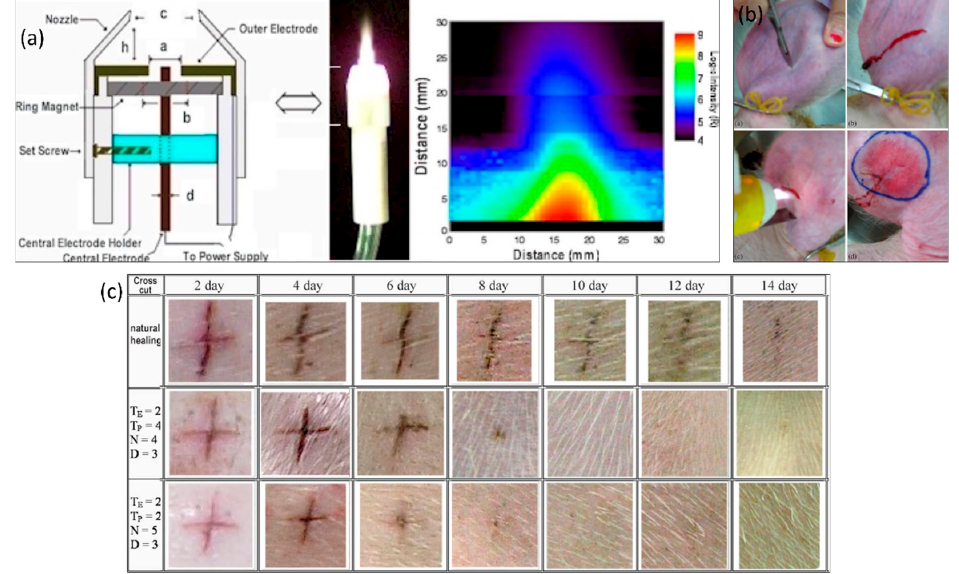
Figure 12. ( a ) The portable plasma spray designed by Kuo [218], ( b ) cutting an artery and leaving the bleeding to stop normally (top row); with plasma treatment the bleeding stops in half time (lower row) and ( c ) comparing the recovery progress of untreated (row 1) and plasma-treated (rows 2 and 3) cross cuts. Reprinted from